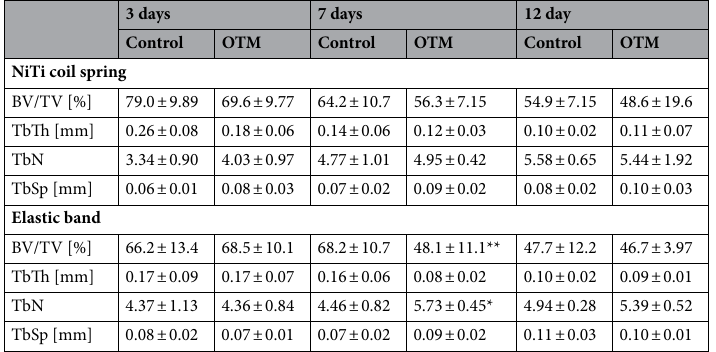
Table 1. Bone parameters after treatment with a NiTi coil spring or an elastic band for three, seven or 12 days. BV/TV bone volume/total volume, TbTh trabecular thickness, TbN number of trabeculae, TbSp trabecular distance. * p ≤ 0.05, ** p ≤